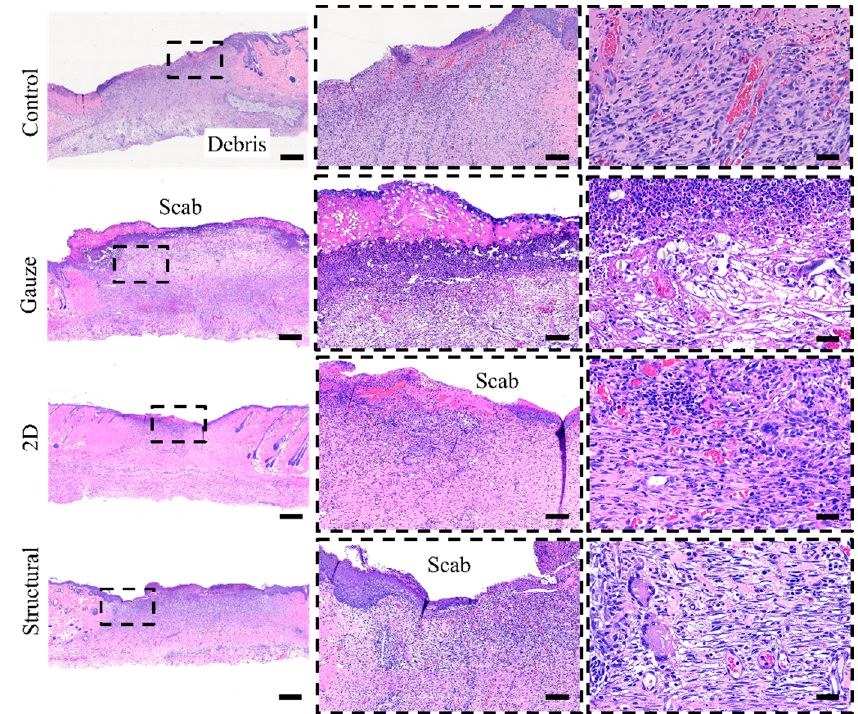
Figure 10. Hematoxylin and eosin (H&E) staining of the healed wound area on day 14. The scale bar represents 600 µm, 100 µm and 30 µm from left to right.